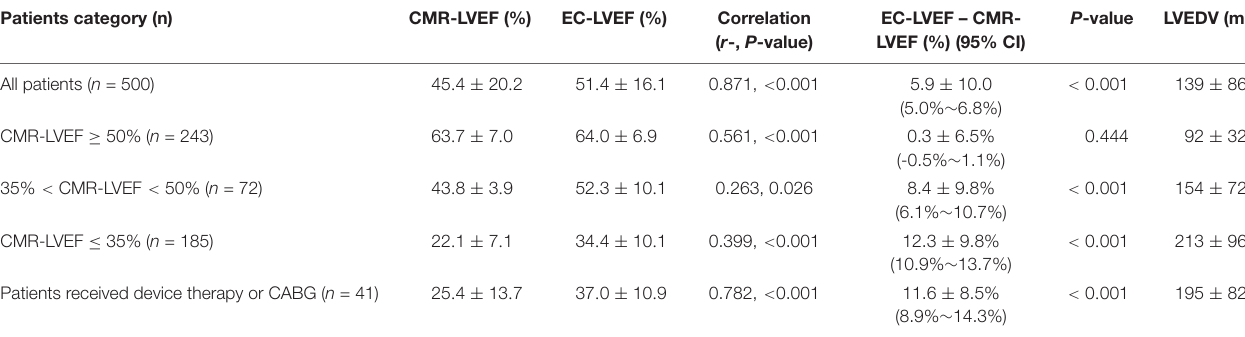
TABLE 1 | Comparison of LVEF between CMR and EC.